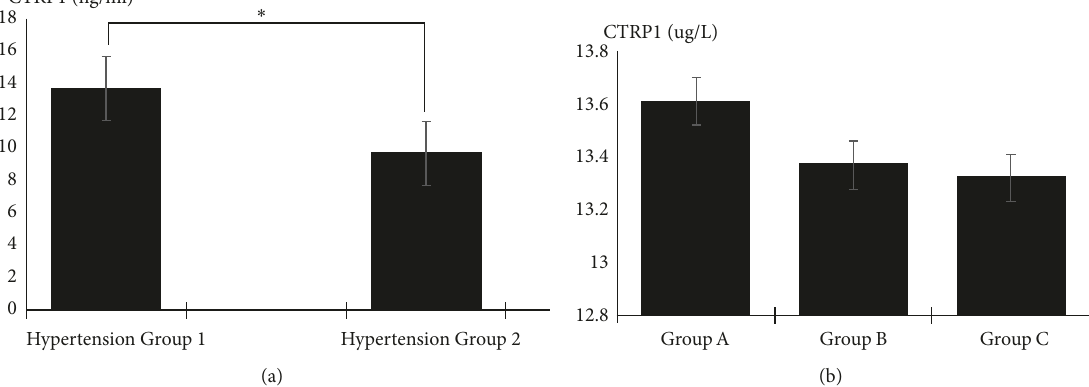
Figure 1: (a) Comparison of CTRP1 concentration between group 1 and group 2. ∗ P < 0.05. (b) Comparison of CTRP1 concentration among three subgroups. CTRP1 levels elevated in Group A significantly.